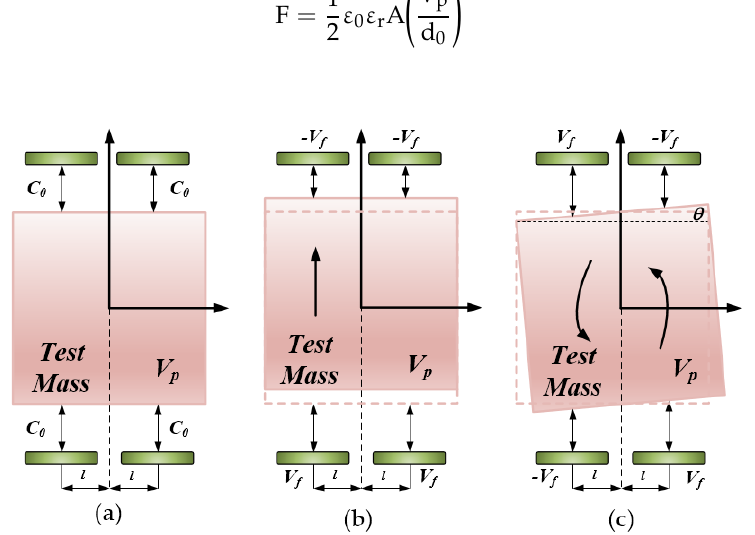
Figure 5. Types of electrostatic force voltage configuration. ( a ) Initial state of the TM; ( b ) Feedback voltage configuration under the TM translation state; ( c ) Feedback voltage configuration under the TM rotation state.